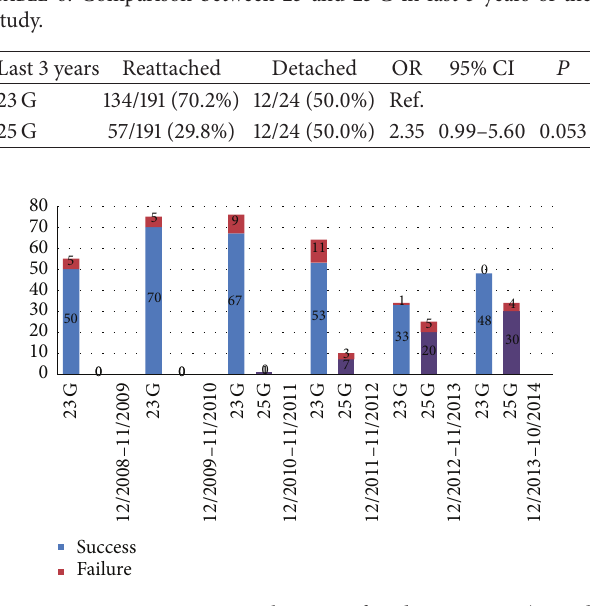
Figure 2: Primary success rate by years of study using PPV (23 and 25